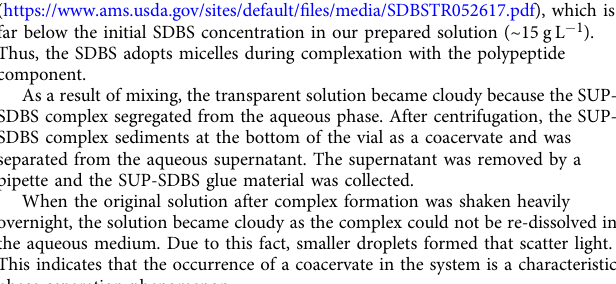
Fig. 4 SUP glue facilitates wound sealing and tissue regeneration in vivo characterized by histological investigation of rat skin tissue in an 8 d post- wounding process. A Different treatments for wound healing, including blank-no treatment, suture closure, commercial medical adhesive COMPONT ® , and SUP glue. Three times each experiment was repeated independently with similar results. Scale bar: 10 mm. B Quantitative analysis of SUP glue